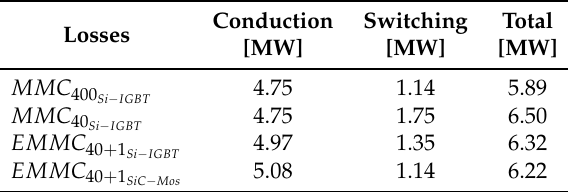
Table 1. Semiconductor loss comparison between modular multilevel converters (MMC) and EMMC